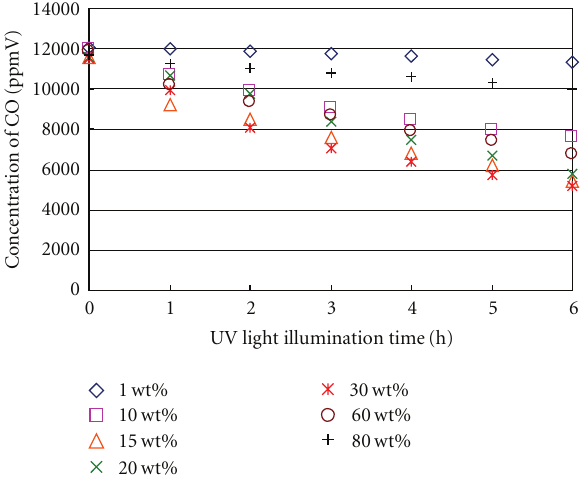
Figure 5: Change of concentration of CO 2 with UV light illumina- tion time for di ff erent loading ratios of TiO 2 . Figure 6: Change of concentration of CO with UV light illumina- tion time for di ff erent loading ratios of TiO 2